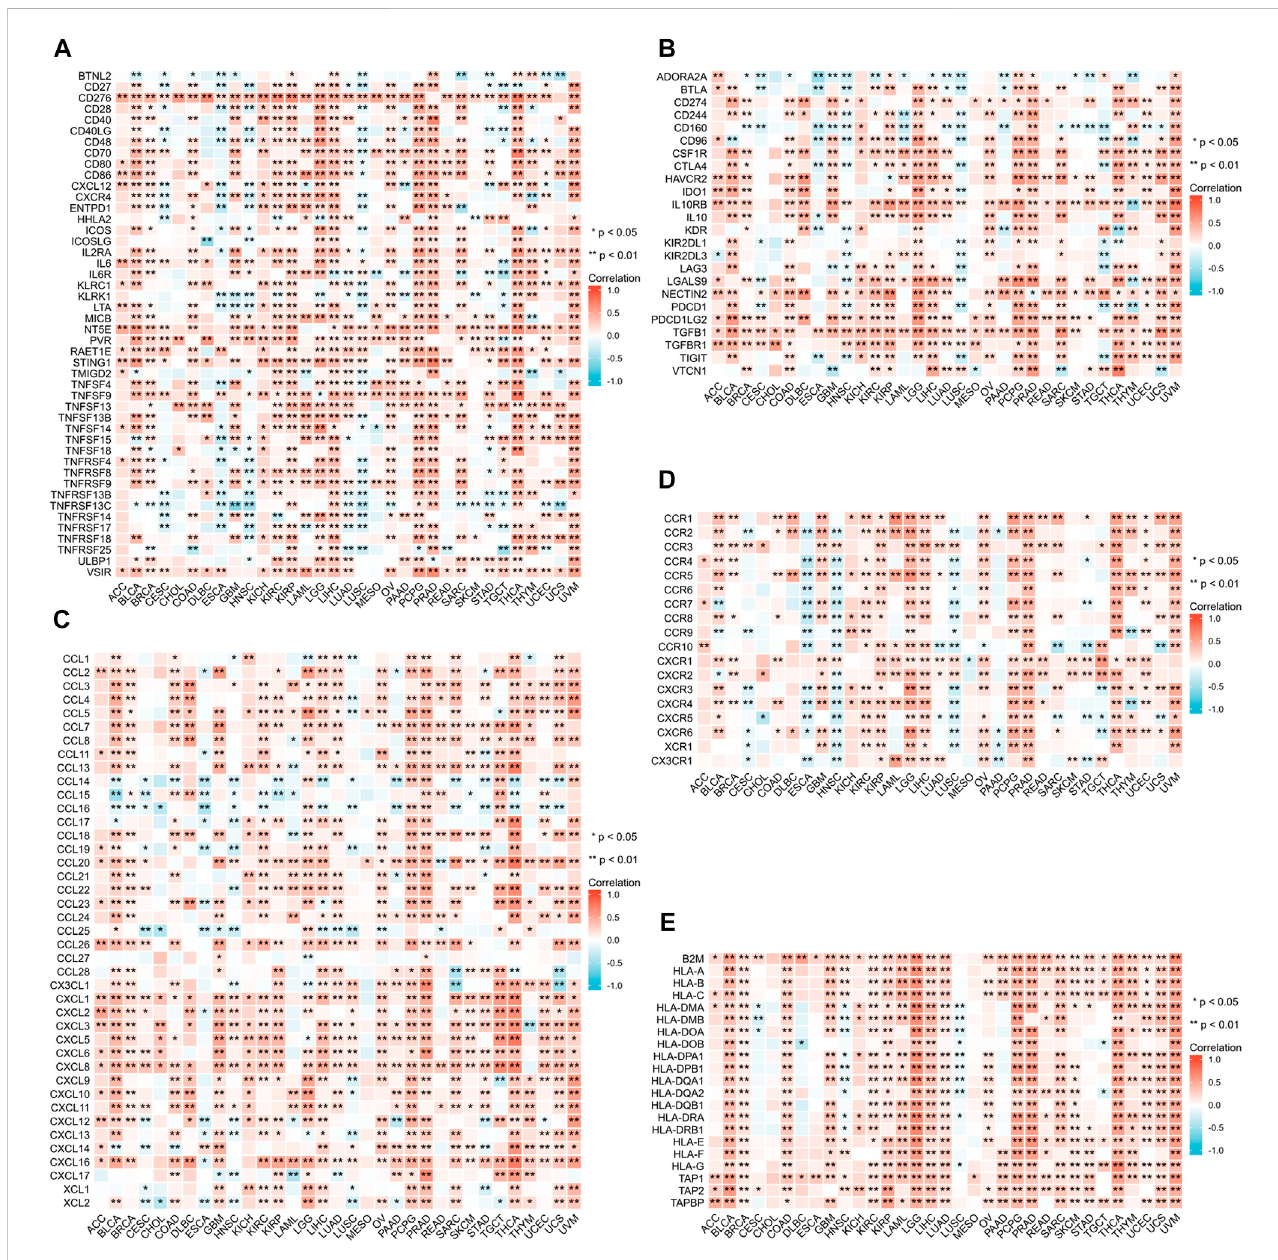
FIGURE 7 Relationship between ANXA2 expression and immunomodulators. (A) Immune-activating genes, (B) Immune-suppressing genes, (C) Chemokine ligands, (D) Chemokine receptors, (E) MHC genes. * p < .05 and ** p <